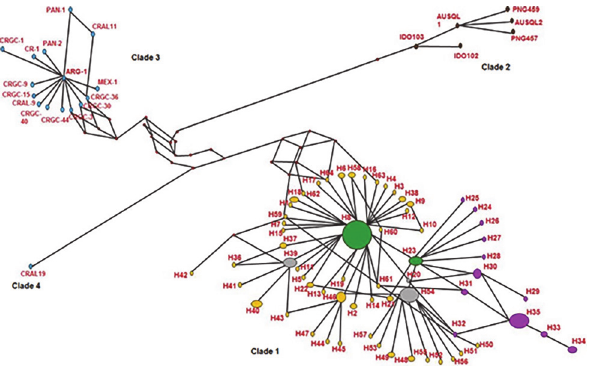
Fig 5. Median-joining haplotype network of the cox1 gene of Maruca spp. in Asia, Africa, Oceania and Latin America. cox1 haplotypes found in the study were included in the network analysis. Haplotype frequency is represented by the size of each node and red nodes represent hypothetical haplotypes (or median vectors). Asian haplotypes were marked in yellow nodes, African haplotypes in purple nodes, Latin American samples in blue nodes, and Oceania haplotypes in brown nodes. Nodes (H8 and H23) containing African, Asian and Australian haplotypes were marked in green, whereas nodes containing Asian and Australian haplotypes were marked in grey. Refer to Table 1 for the haplotype numbers and their corresponding M . vitrata population details used in this study. Countries abbreviated in this figure are as follows: AUSQL — Australia (Queensland); CRAL — Costa Rica (Alajuela); CRGC — Costa Rica (Guanacaste); MEX — Mexico; ARG — Argentina; PAN — Panama; IDO — Indonesia (Kalimantan); PNG — Papua New